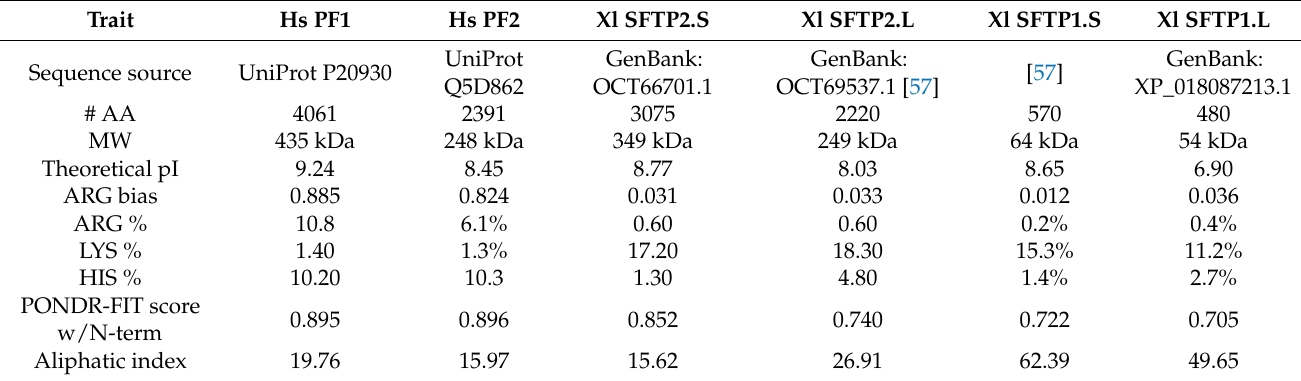
Table 2. SFTP characteristics across species. Sequences were submitted to https://web.expasy.org/protparam/ and http://original.disprot.org/pondr-fit.php (accessed 5 February 2021). Arginine bias: calculated as ARG/[ARG + LYS]. PONDR-FIT scores are averaged across the sequence entire length, including the likely structured S100-type amino terminus. Trait Hs